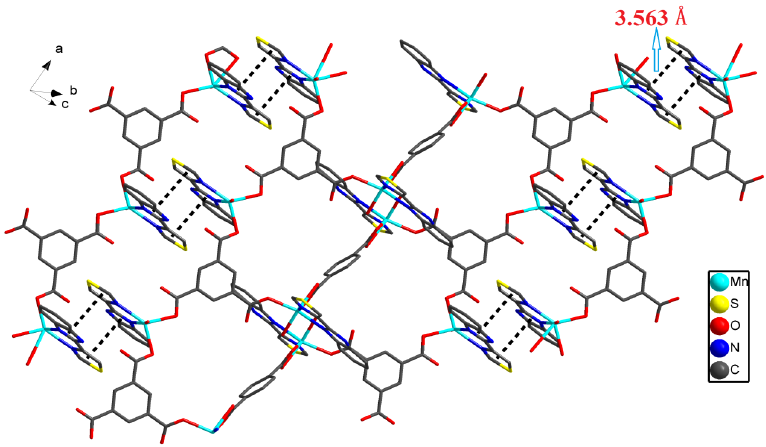
Figure 7. The face to face π – π stacking interactions between two heterocyclic of different TBZ ligands in complex 2 , all H atoms are omitted for clarity.